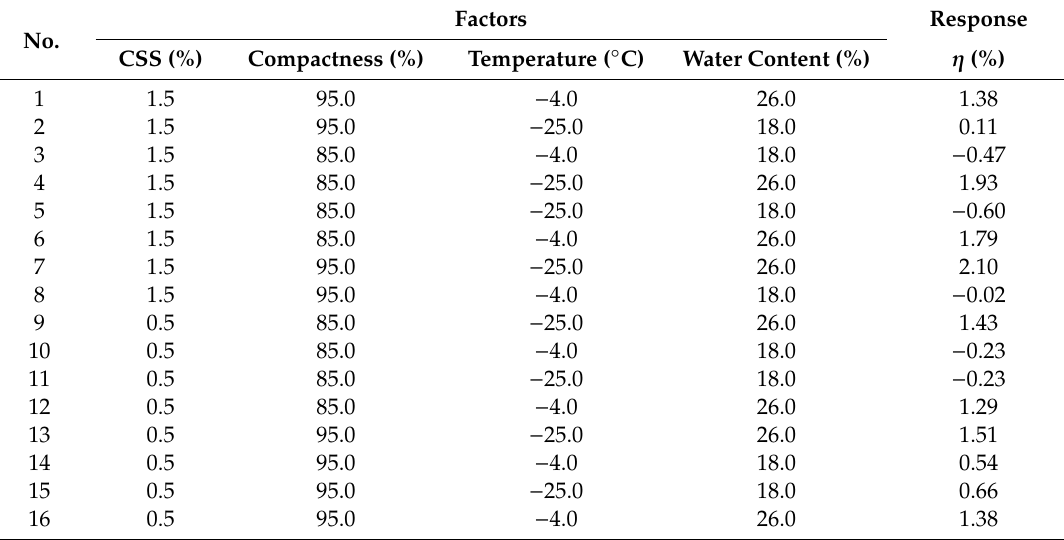
Table 3. Schedule and results of improved frost heave